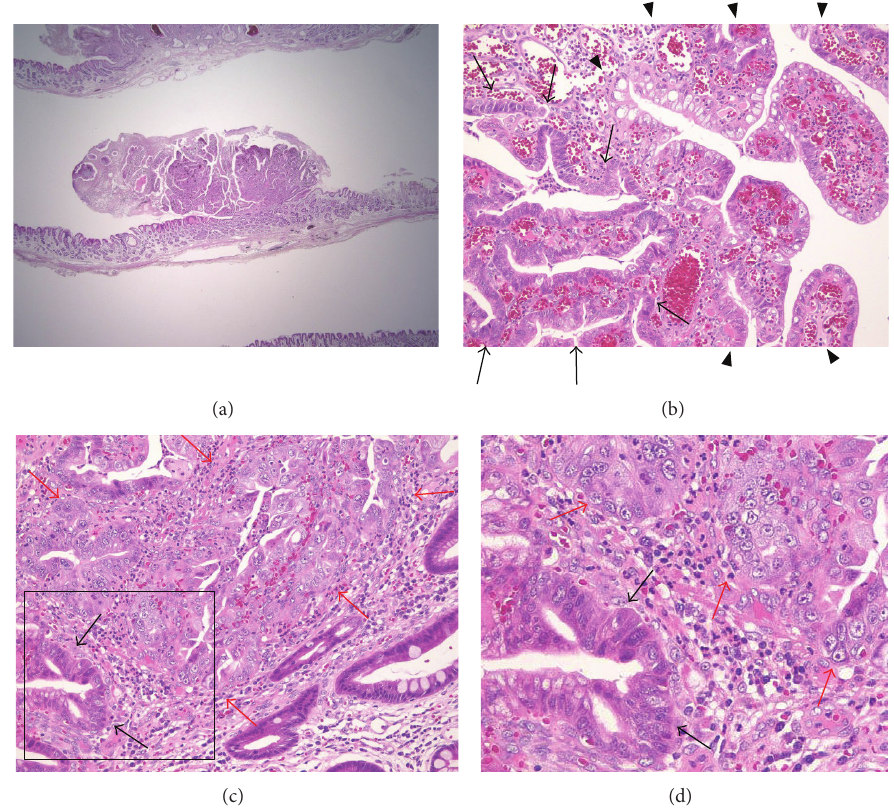
Figure 2: Case 1, histopathological findings. (a) Resected specimen obtained by endoscopic ESD (H&E, × 4). (b) Foci of tubular adenoma with mild dysplasia (between the arrows) in the setting of HP (between arrowheads) are noted (H&E, × 20). (c) Foci of carcinomatous transformation (between red arrows) adjacent to the adenomatous lesion (black arrows) in sequence are observed (H&E, × 20). (d) The black box in (c) depicts the position of the enlarged section. Red arrows: foci of carcinomatous transformation; black arrows: adenomatous lesion. ESD: endoscopic submucosal dissection; HP: hyperplastic